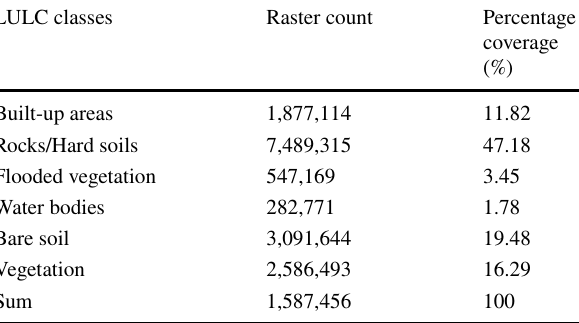
Fig. 8 LULC map of Bosso LGA Table 6 LULC class